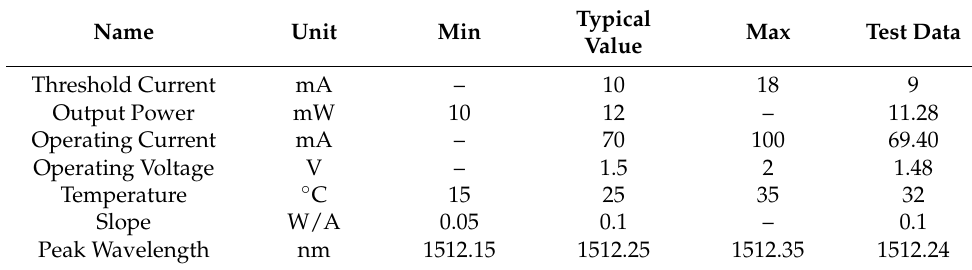
Figure 2. Output wavenumber of the DFB laser versus drive current at 20 °C, 22 °C, 24 °C, 26 °C, 28 °C, 30 °C, and 32 °C. The red line is the linear fitting line of the selected temperature (32 °C). The slope of the fitting line is 0.06156, which is the reciprocal of the slope of the black line shown in Figure 1b. Table 1. The typical value and test value of the selected DFB laser characteristics.